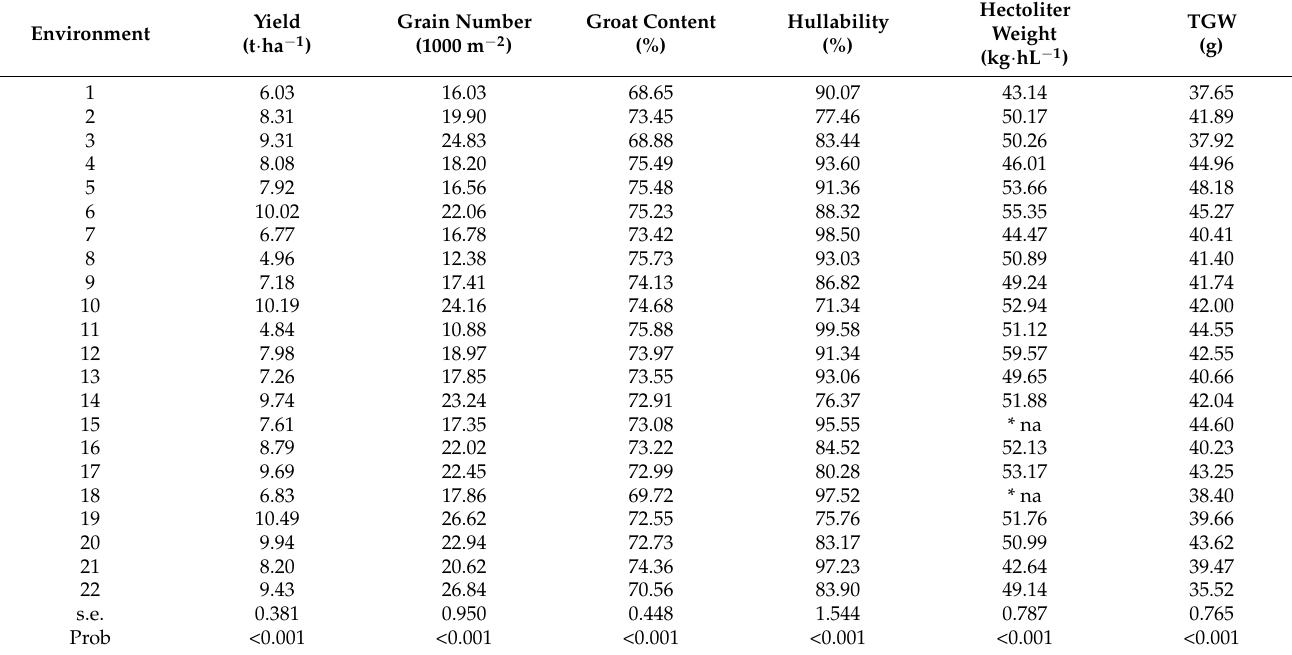
Table 2. Effect of environment on the harvested yield (t · ha − 1 ), grain quality and thousand grain weight (TGW) of four winter oat varieties grown in 22 environments. Data are presented as the mean of the 4 winter oat varieties in each environment.